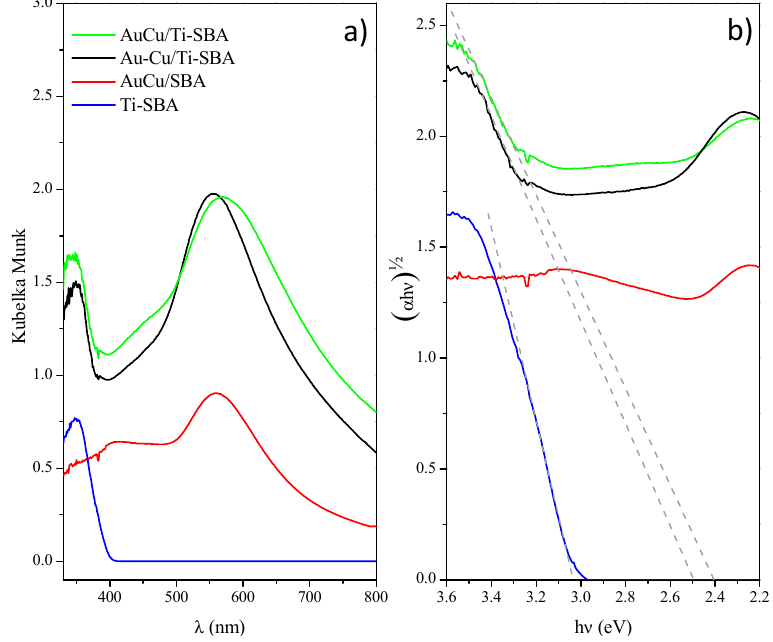
Figure 10. ( a ) Diffuse reflectance ultraviolet-visible (DRUV-vis) spectra of the samples and ( b ) ( α h ν ) ½ vs. photoenergy (h ν ).